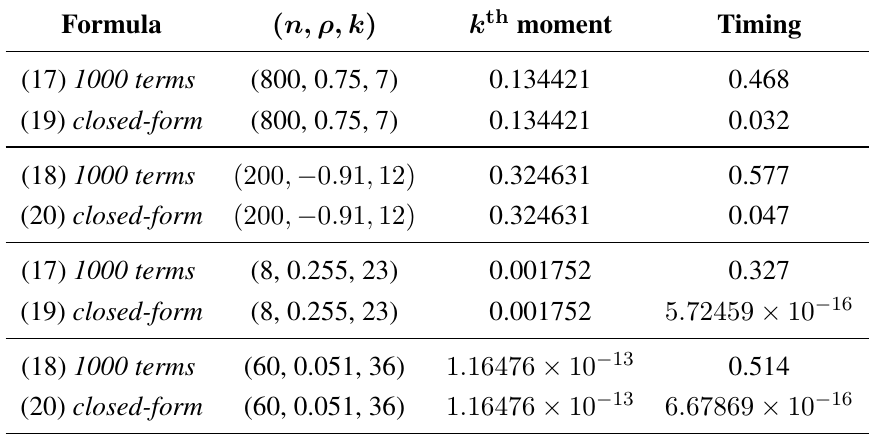
Table 3. Certain moments of R and associated computing times in